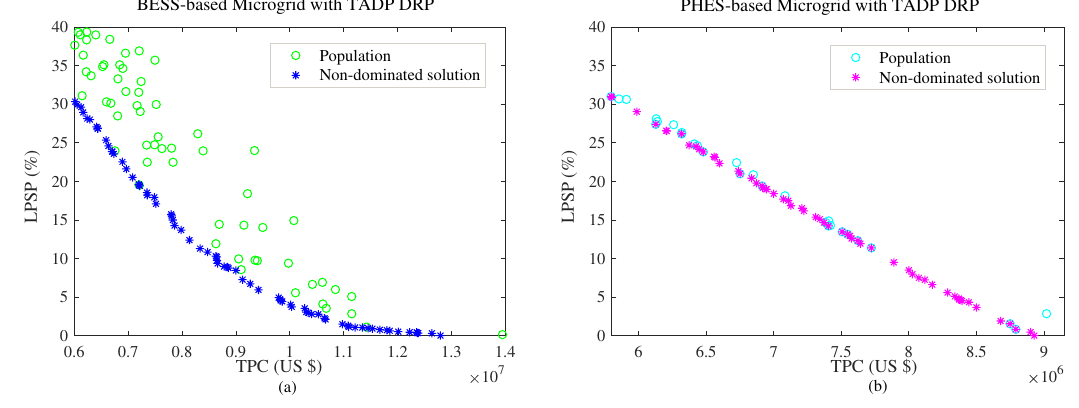
Figure 8. Pareto front plots for case 3. Table 6. Techno-economic analysis for case